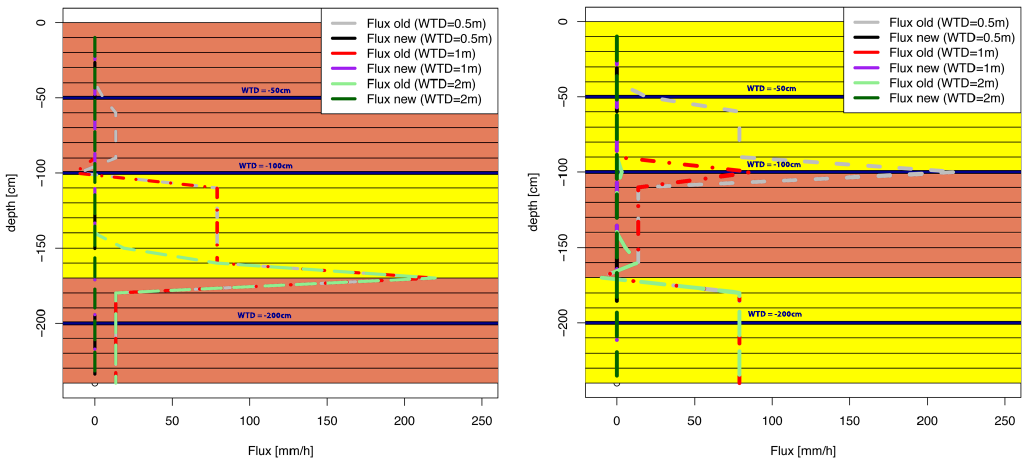
Figure 3. (left) Same as Fig. 2a, except using WTDs within the model domain at 0.5, 1 and 2m (indicated by the blue lines). Results of the new formulation of RE (black, purple and dark green lines) overlap each other. (right) Same as (left) except using a sand-loam-sand soil type